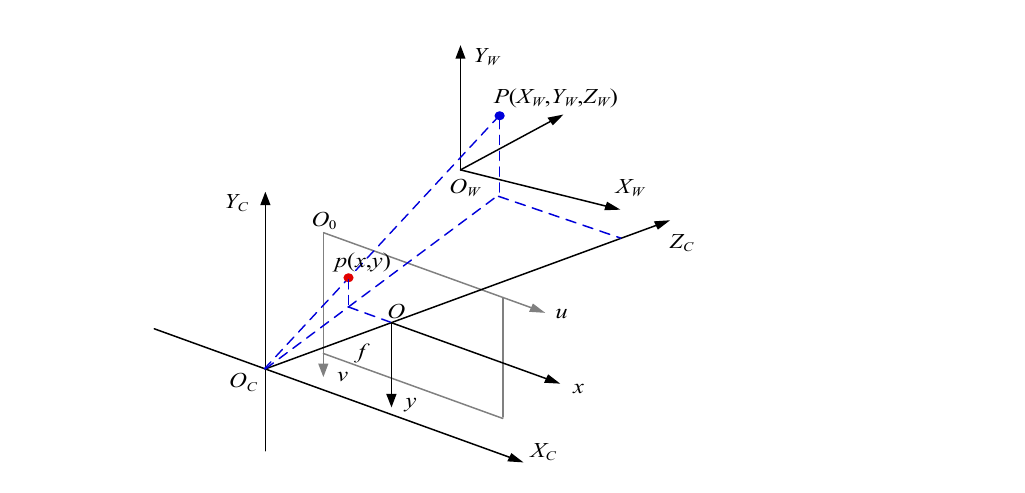
Figure 5. Transformation between the world coordinate system, the camera coordinate system, and the image coordinate system.